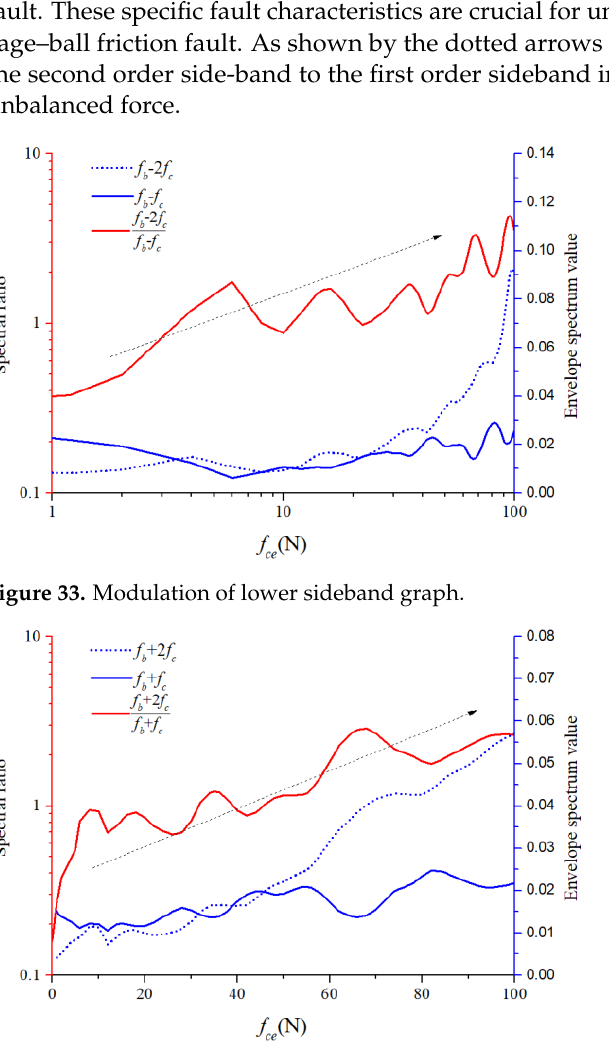
20 of 27 Figure 32. Acceleration waveform.